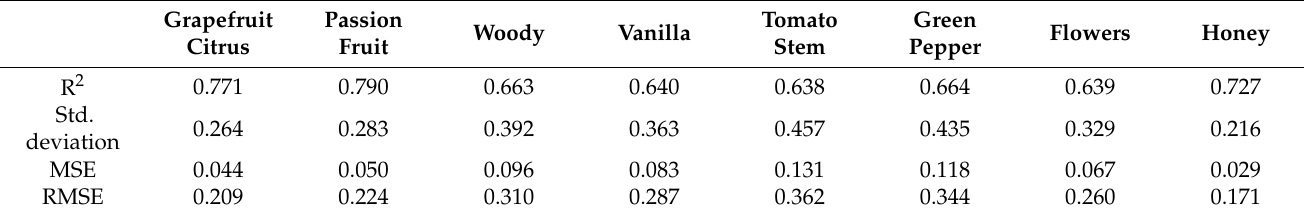
Table 8. Quality index for PLS regression on aroma descriptors for Sauvignon Blanc.